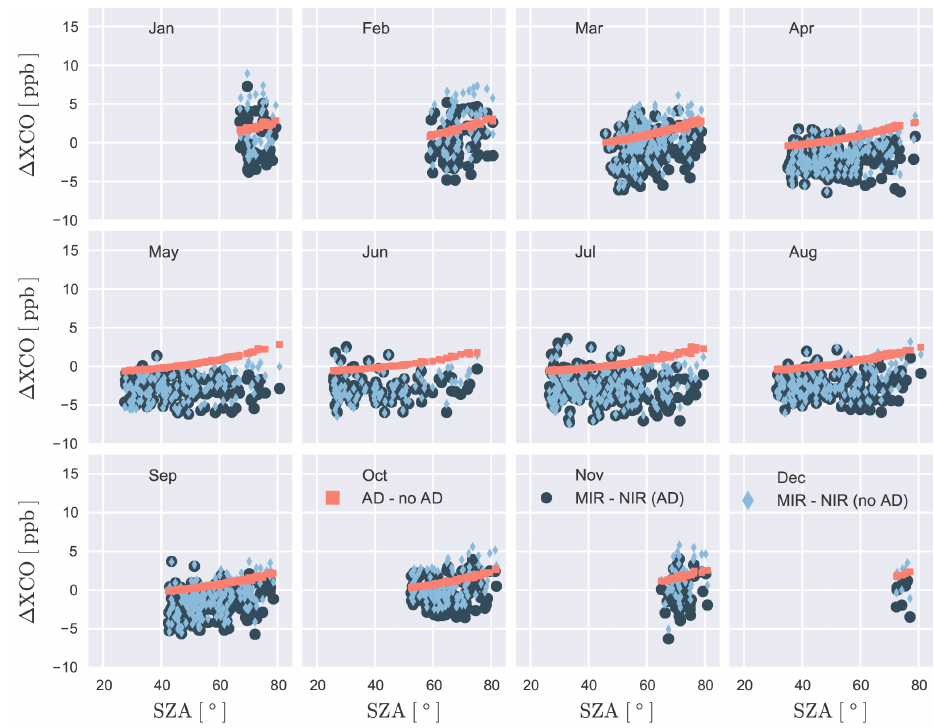
Figure A5. Air-mass-dependent XCO differences between NDACC and TCCON. Depicted are absolute differences between NDACC and TCCON when AD is applied (MIR − NIR AD), NDACC and TCCON when no AD is applied (MIR − NIR no AD), and the direct impact of applying AD in the TCCON retrieval (AD − no